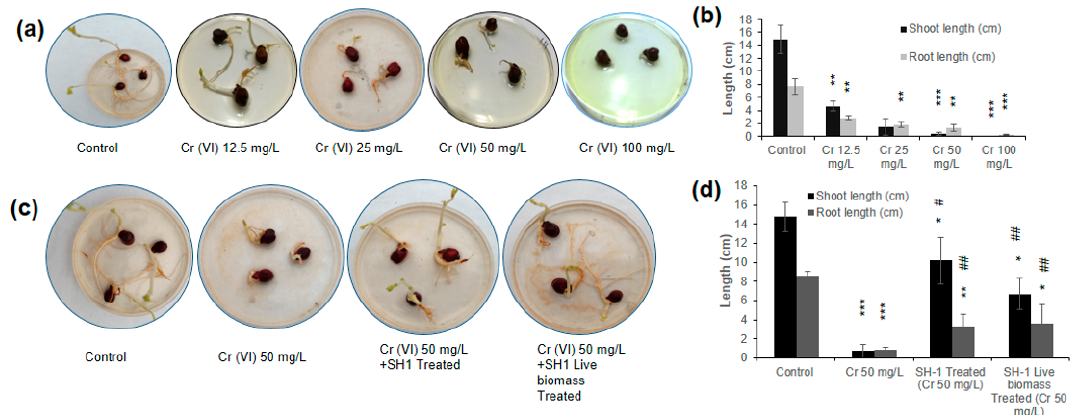
Figure 5. Phytotoxicity test using chickpea seeds. ( a ) Determination of toxicity of different concentrations of Cr(VI) on seed germination and growth. ( b ) The mean shoot and root length of the seeds of Figure 5a. ( c ) Images of reduction of the toxicity of Cr(VI) by bacterial treated samples. ( d ) The mean shoot and root length of the treated seeds of Figure 5c. In Figure 5b,d, paired two-tailed students t -test was performed between control and the study group and data are expressed as mean ± standard deviation (SD). “ * ” denotes significant differences between control group and study group ( * p <0.05, ** p < 0.01, *** p < 0.001). “#” indicates significant differences between Cr(VI) 50 mg/L and study group (# p <0.05, ## p < 0.01).